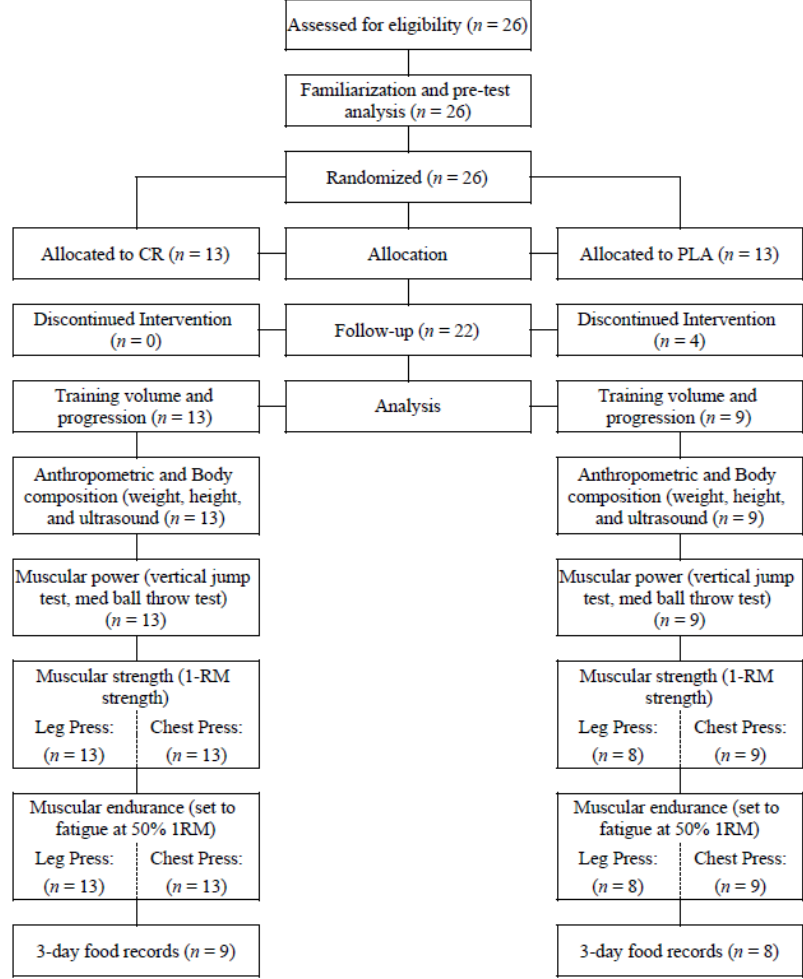
Figure 1. Summary of recruitment, allocation and analyses. Table 1. Baseline characteristics.